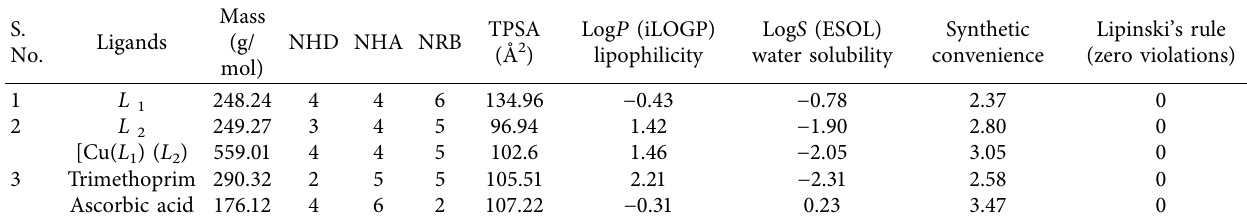
Table 6: Drug-likeness analysis of L 1 and L 2 estimation by Swiss